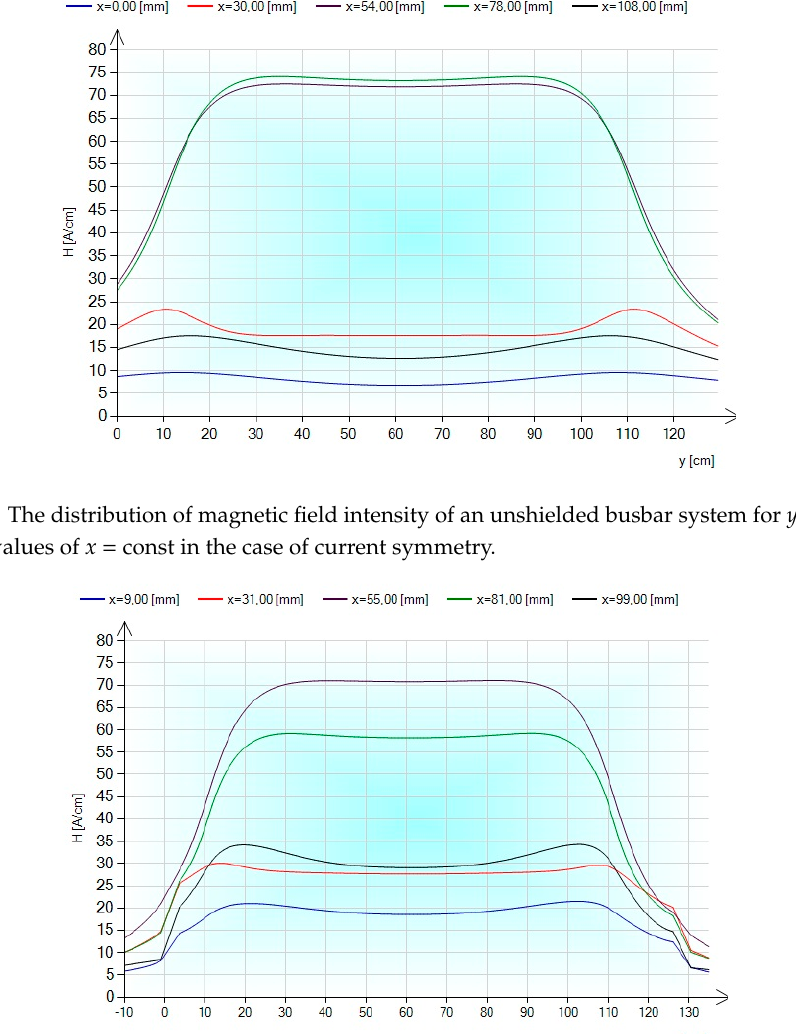
Figure 13. The distribution of magnetic field intensity of a shielded busbar system for x = var and different values of y = const in the case of current symmetry.